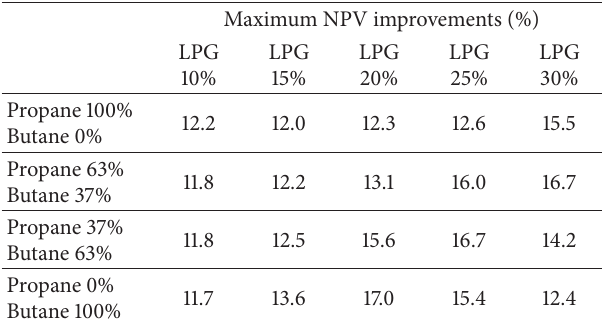
Table 8: Maximum NPV improvements with LPG mole fraction and composition for water-wet reservoir (base case: